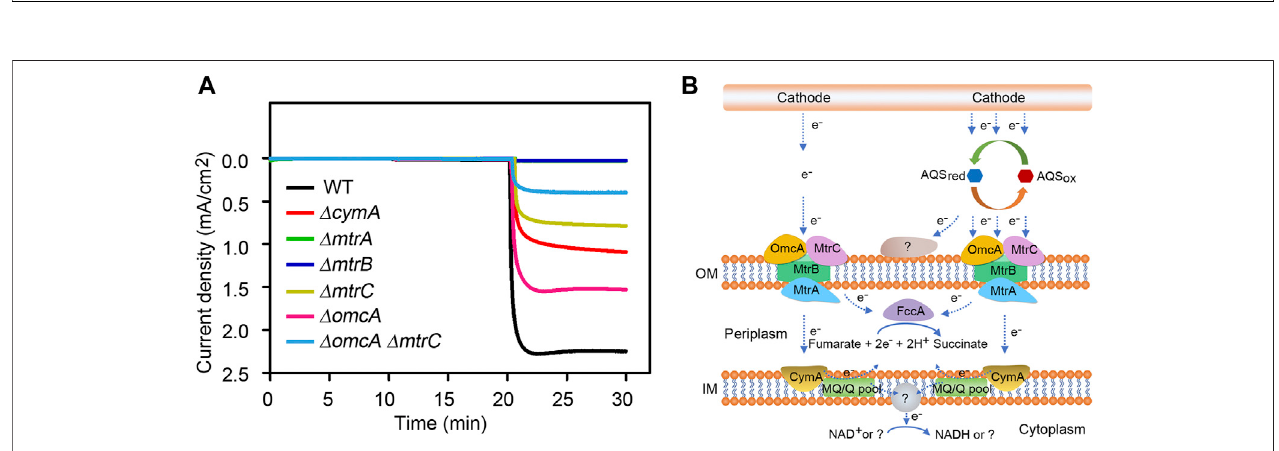
FIGURE 4 | Role of Mtr pathway in AQS-mediated cathodic EET process of S. oneidensis MR-1. (A) Measurements of current density in deletion mutants lacking different Mtr-associated proteins. (B) A simple model on the AQS-mediated cathodic EET mechanism? symbol indicates unidenti fi ed enzyme, substrate or product.